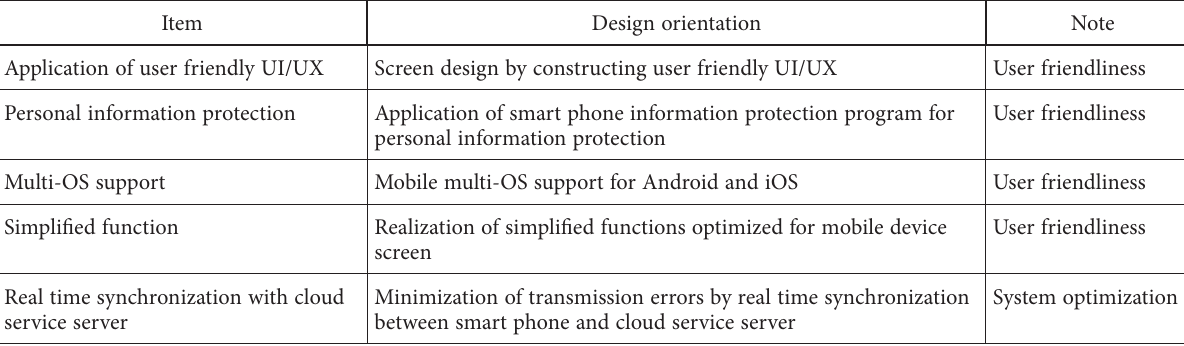
Table 2. Design item and orientation for non-point pollution sources survey and management Item